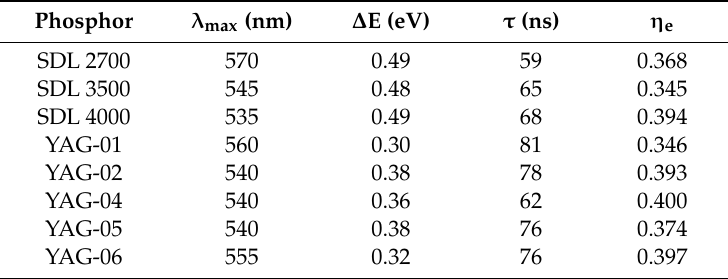
Table 2. Characteristics of photoluminescence (PL) at 530–560 nm in the SDL and C-YAG phosphors under excitation at 460 nm: the position of the luminescence peak ( λ max ), the full width at half maximum (FWHM) of the emission band ( ∆ E), the characteristic decay time ( τ ), and the energy yield of the energy conversion ( η e ) at λ ex = 447